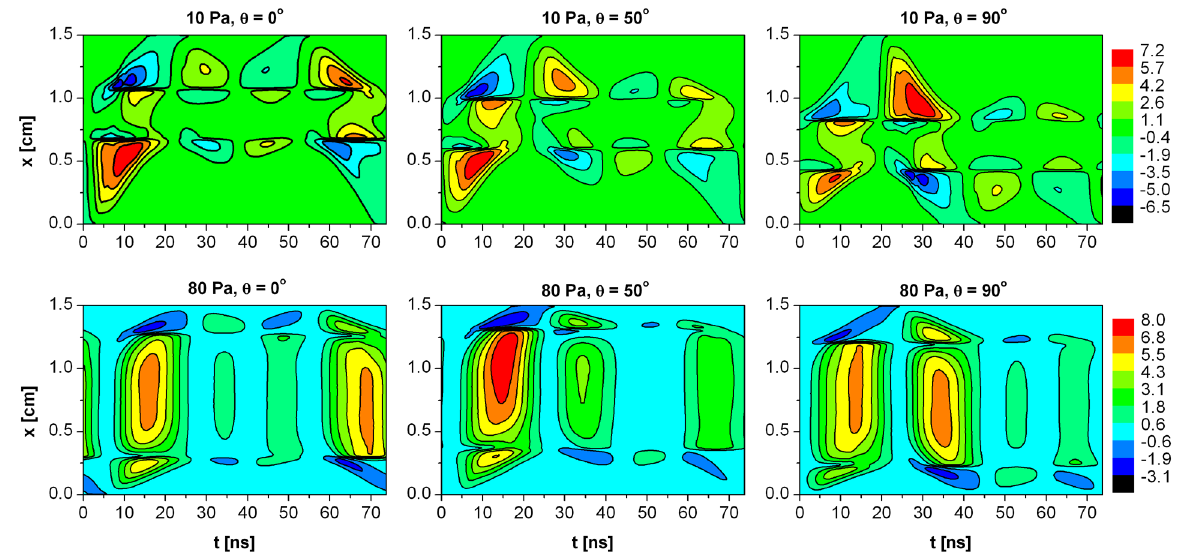
Figure 7 : Spatio-temporal distribution of the electron heating rate in electrically asymmetric dual-frequency discharges operated at 13.56 MHz + 27.12 MHz for different values of the phase shift between the driving harmonics, θ, at 10 Pa, Φ Φ =Φ = 50 V (second row). The color scales are given in 10 4 Wm -3 and apply to all plots in the same LF HF